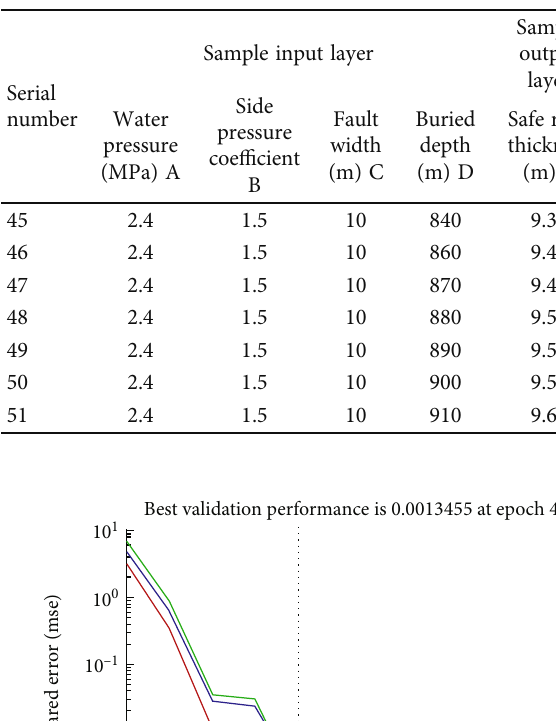
Table 8: Training sample data.